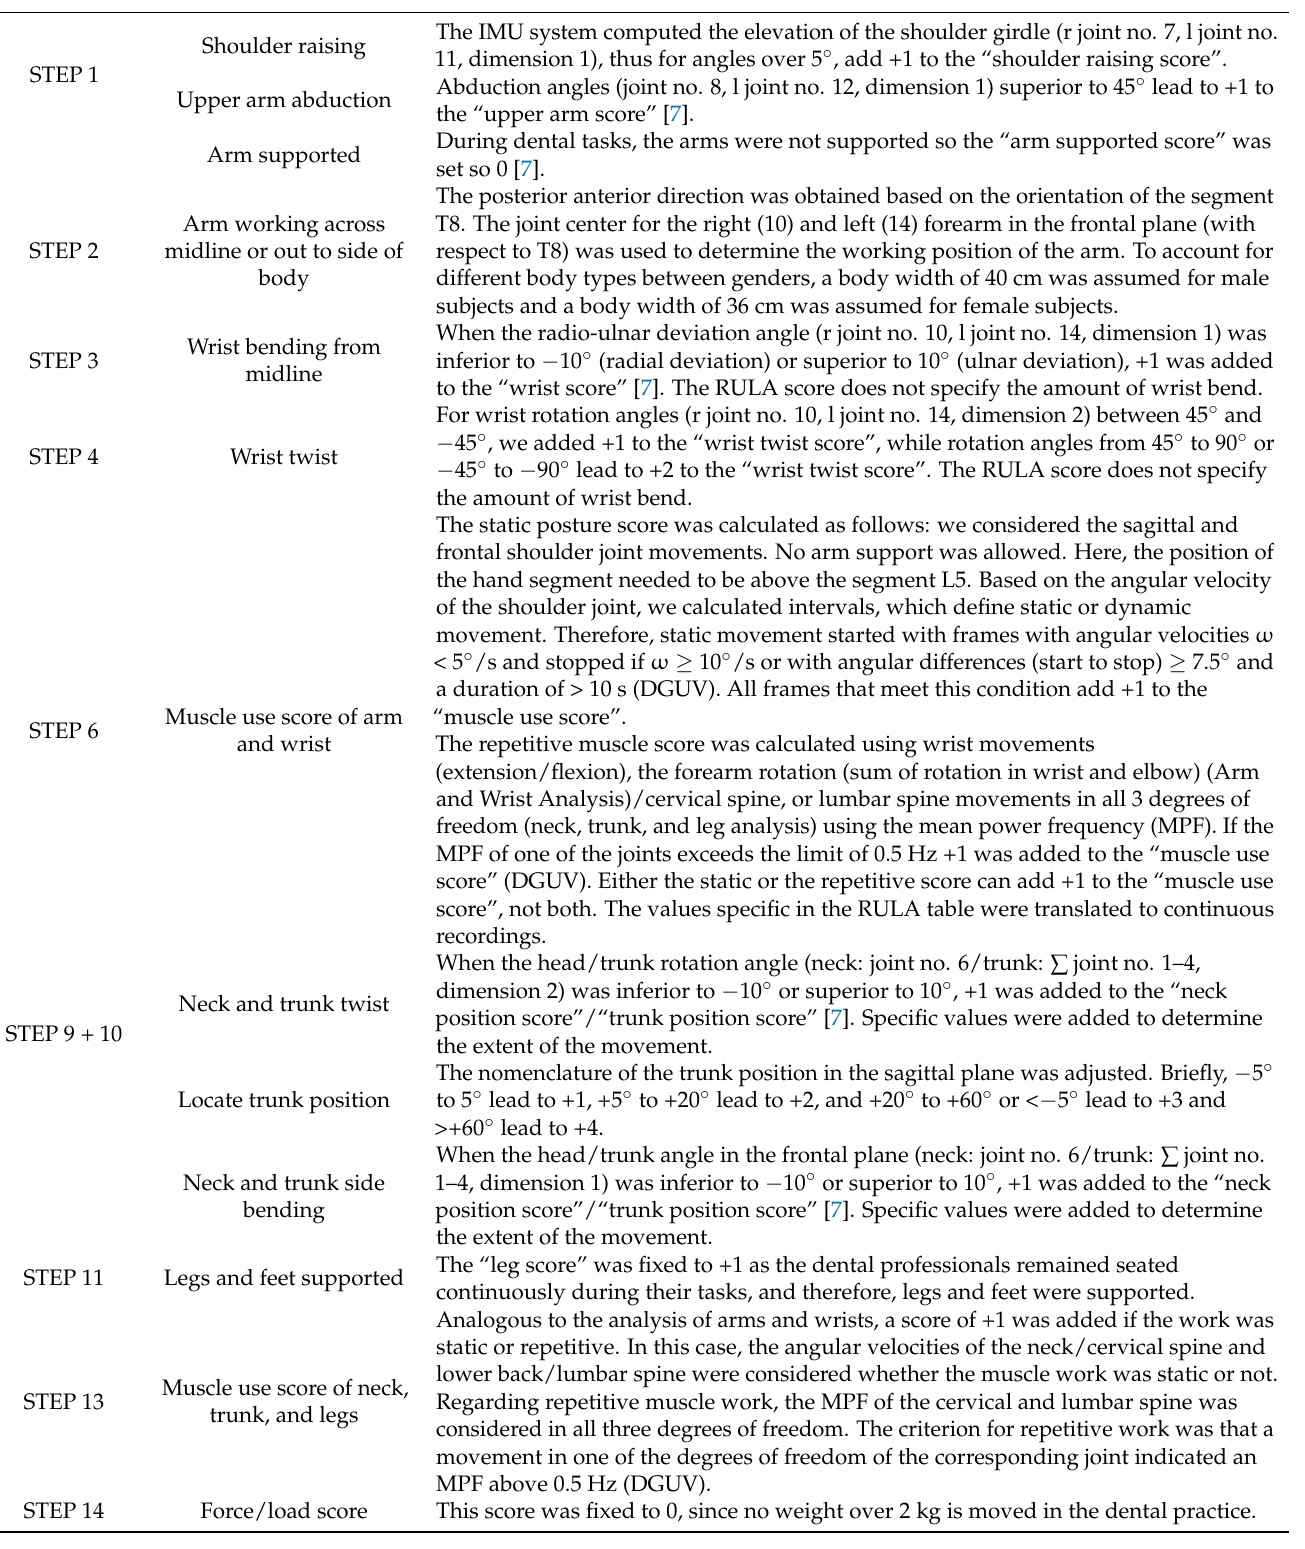
Table A1. RULA modifications. This table is an extension of Table 1. We added information about the specific joint number and degree of freedom of the Xsens software of each parameter. Furthermore, we explained in detail how the muscle use score was